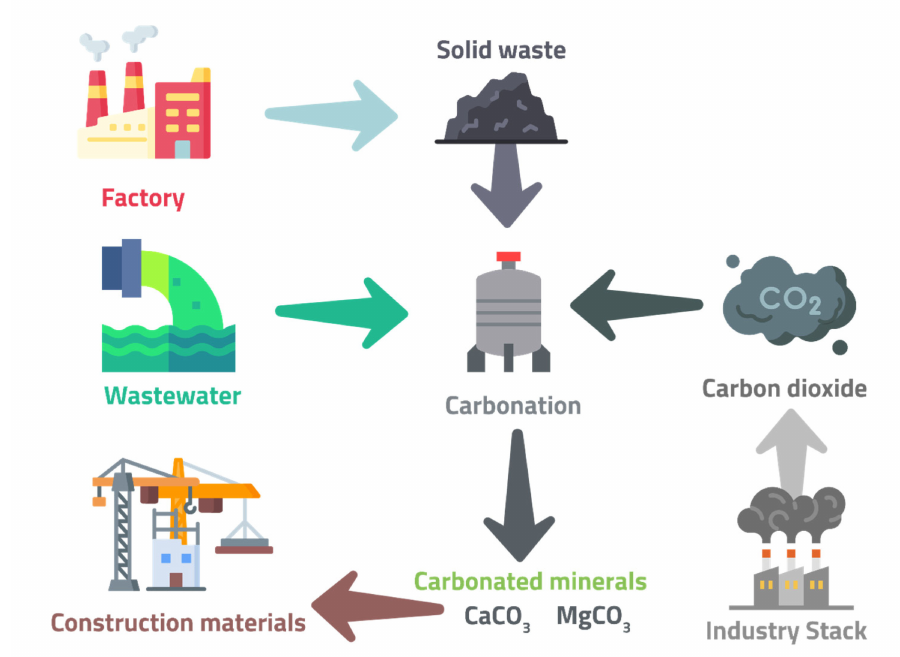
Figure 6. Ex situ Direct Aqueous Carbonation (one-step carbonation), adapted from Pan et al.